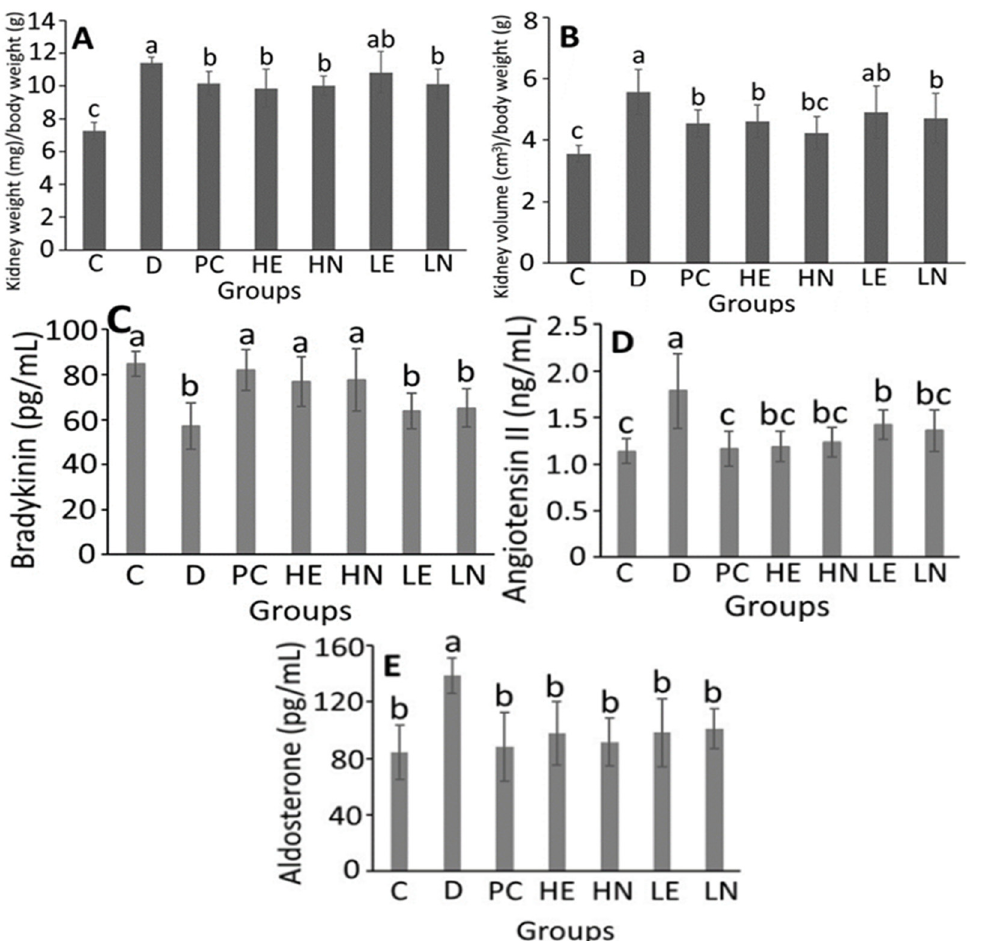
Figure 2. Effect of the administration of black garlic extract and nanoemulsion onkidney weight ( A ), kidney volume ( B ), bradykinin ( C ), angiotensin II ( D ) and aldosterone ( E ) in DOCA-salt-induced hypertension and its associated mild cognitive impairment in rats. Data are presented as means ± standard deviation ( n = 6); C, control; D, DOCA-salt at a dose 25 mg/kg BW; PC, DOCA-salt with the administration of lisinopril at a dose 15 mg/kg BW; HE, DOCA-salt with the administration of black garlic extract at a dose of 100 mg/kg BW; HN, DOCA-salt with the administration of black garlic nanoemulsion at a dose of 100 mg/kg BW; LE, DOCA-salt with the administration of black garlic extract at a dose of 50 mg/kg BW; LN, DOCA-salt with the administration of black garlic nanoemulsion at a dose of 50 mg/kg BW. Values with different small letters (a–c) are significantly different ( p < 0.05).